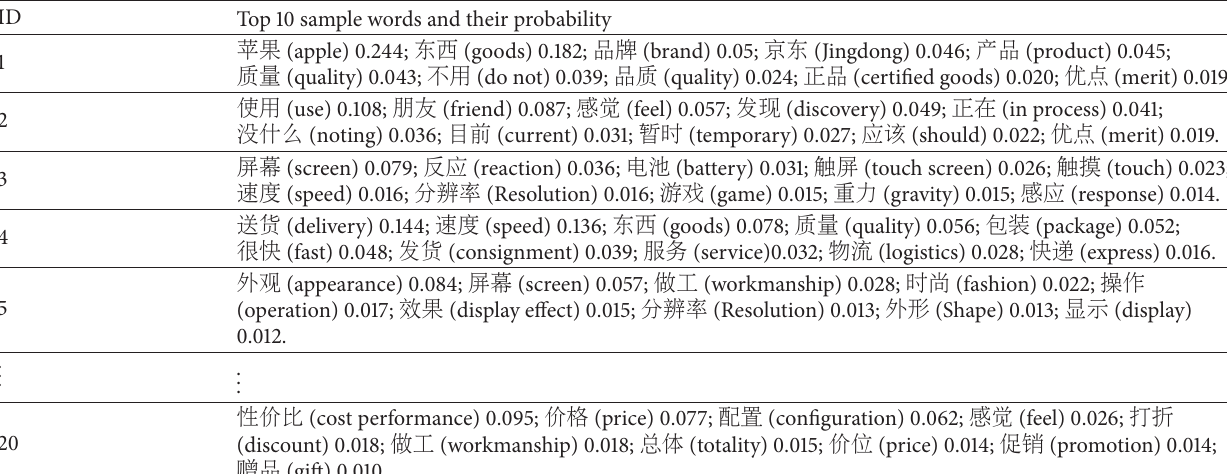
Table 4: Sample topics generated directly by LDA.